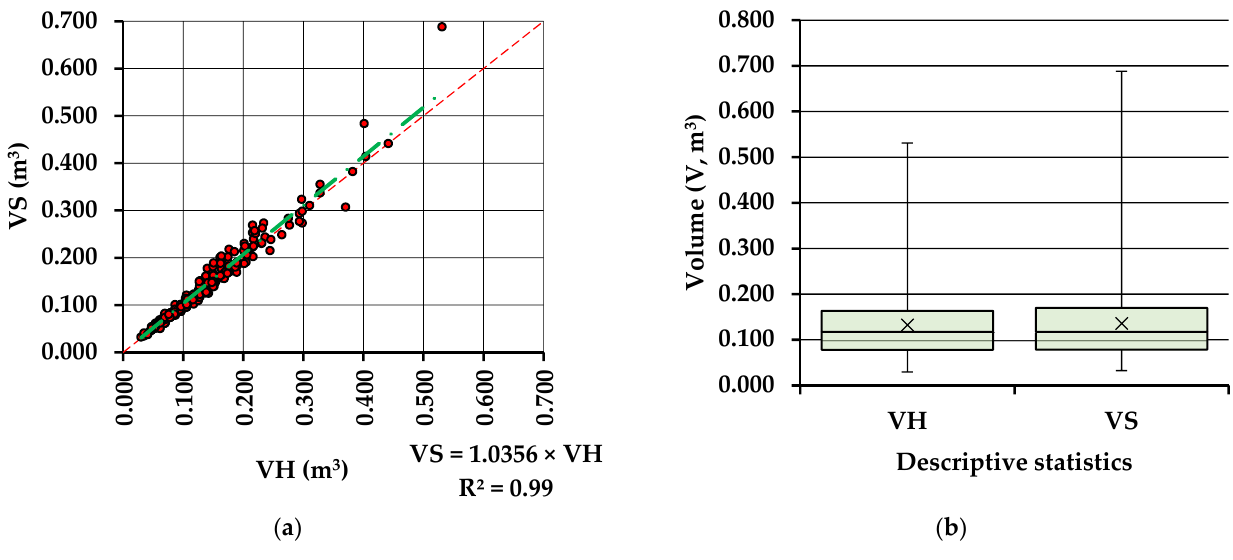
Figure 4. Descriptive statistics of the estimated log volume (E1): ( a ) A comparison between VS and VH, where the red dashed line stands for perfect agreement (equality line) and the green dot-dash line stands for the dependence relation between VS and VH fitted by RTO; ( b ) boxplots showing the summary of data distribution and the main descriptive statistics of the volume estimates, including the minimum, mean, median and maximum value.